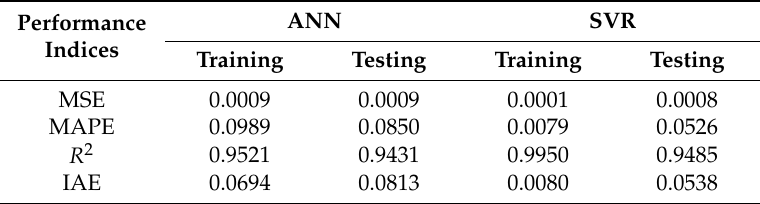
Table 7. Performance indices of ANN and SVR